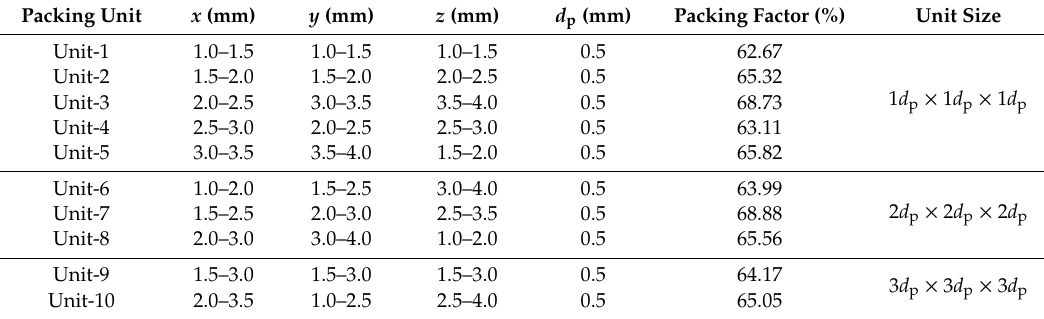
Table 2. Typical packing parameters for random packing units.